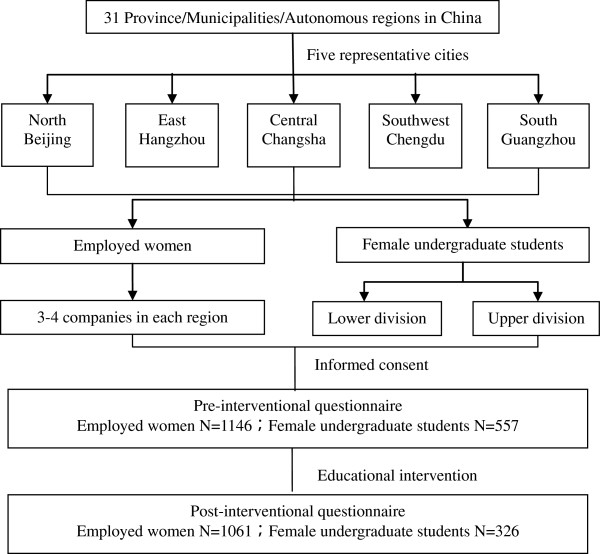
Study flowchart.